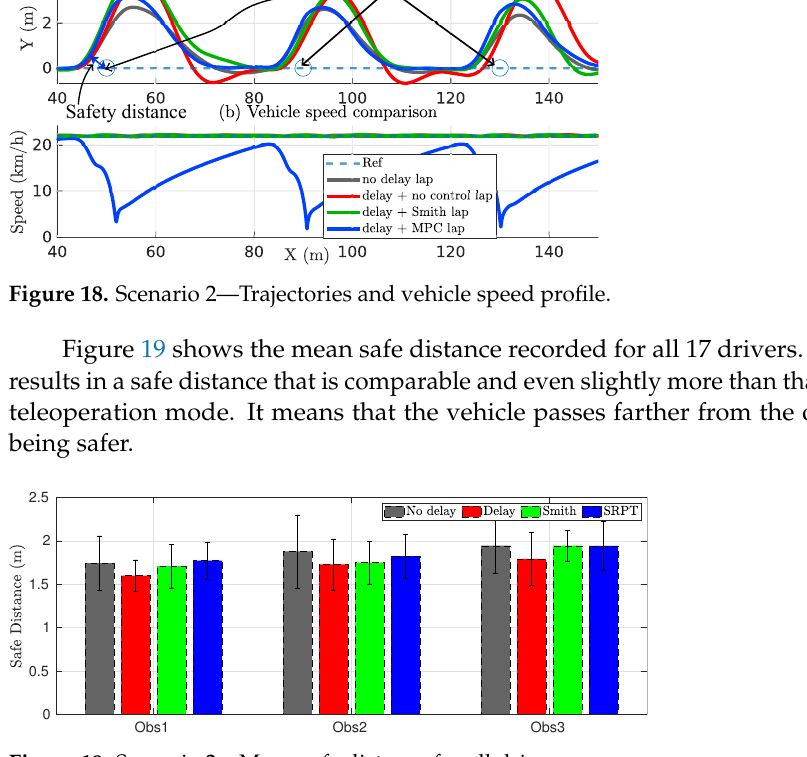
Figure 19. Scenario 2—Mean safe distance for all drivers.